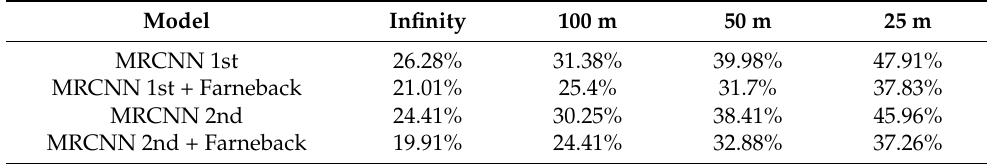
Table 3. Depth influence on AP , Cityscapes dataset